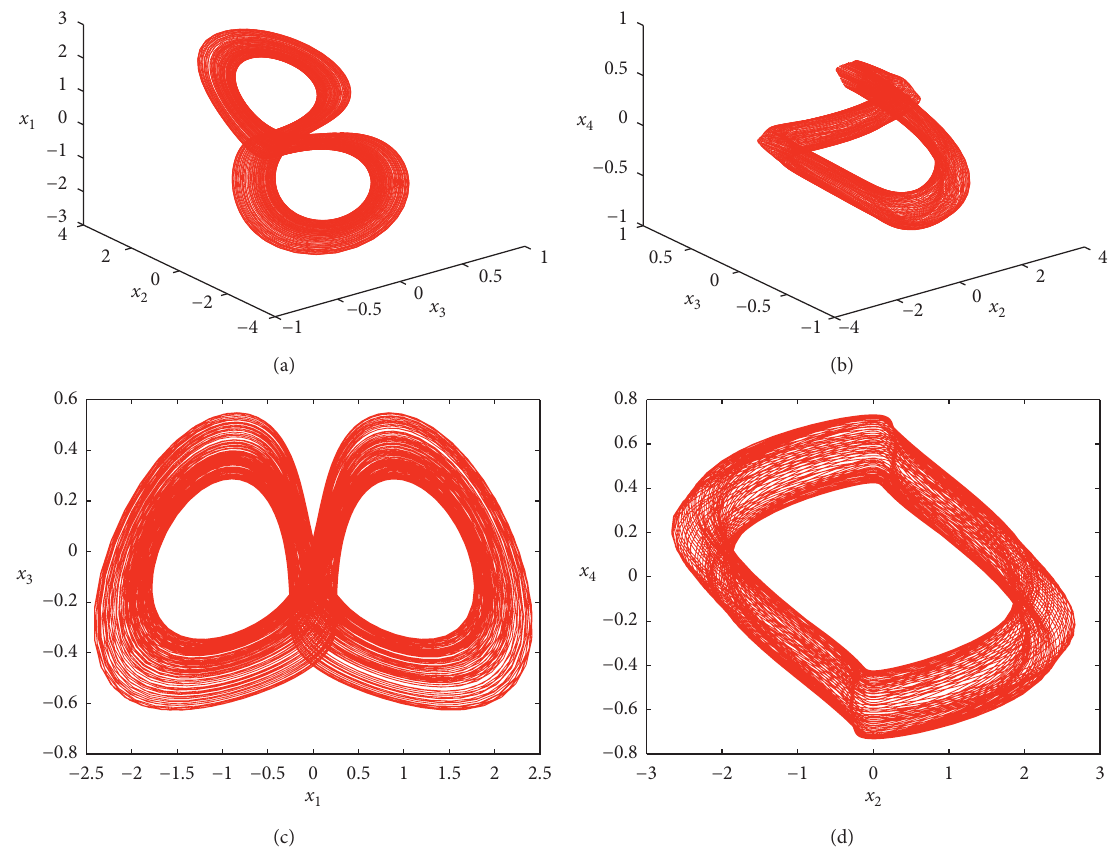
Figure 3: Quasiperiodic motion of system (2) with a � 12, b � c � 1, and k � 12: (a) x